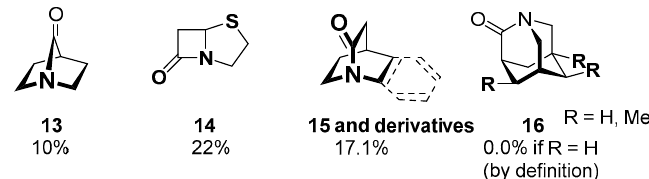
Figure 8. Typical examples of synthetized twisted amides ( 13 – 16 ) with the corresponding amidicity computed at B3LYP/6-31G(d,p) level of theory.